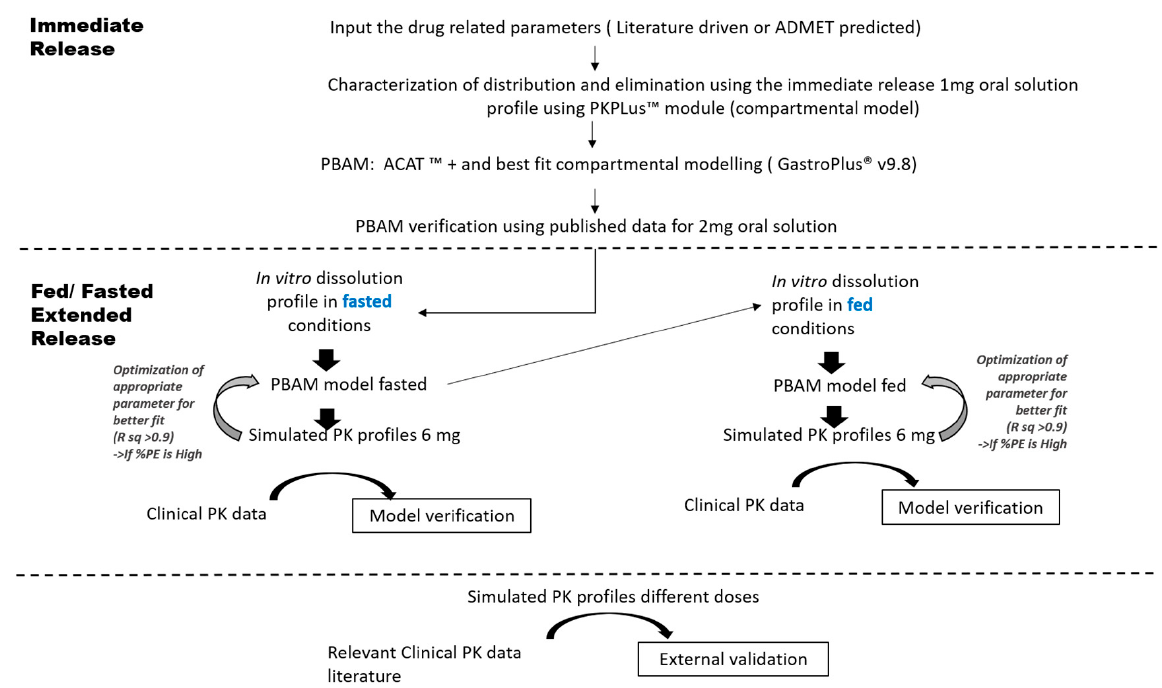
Figure 2. A schematic diagram describing the development and verification of the PBAM model for PAL under fasted and fed conditions. PBAM: physiologically based absorption modeling; PK: Phar ‐ macokinetics.